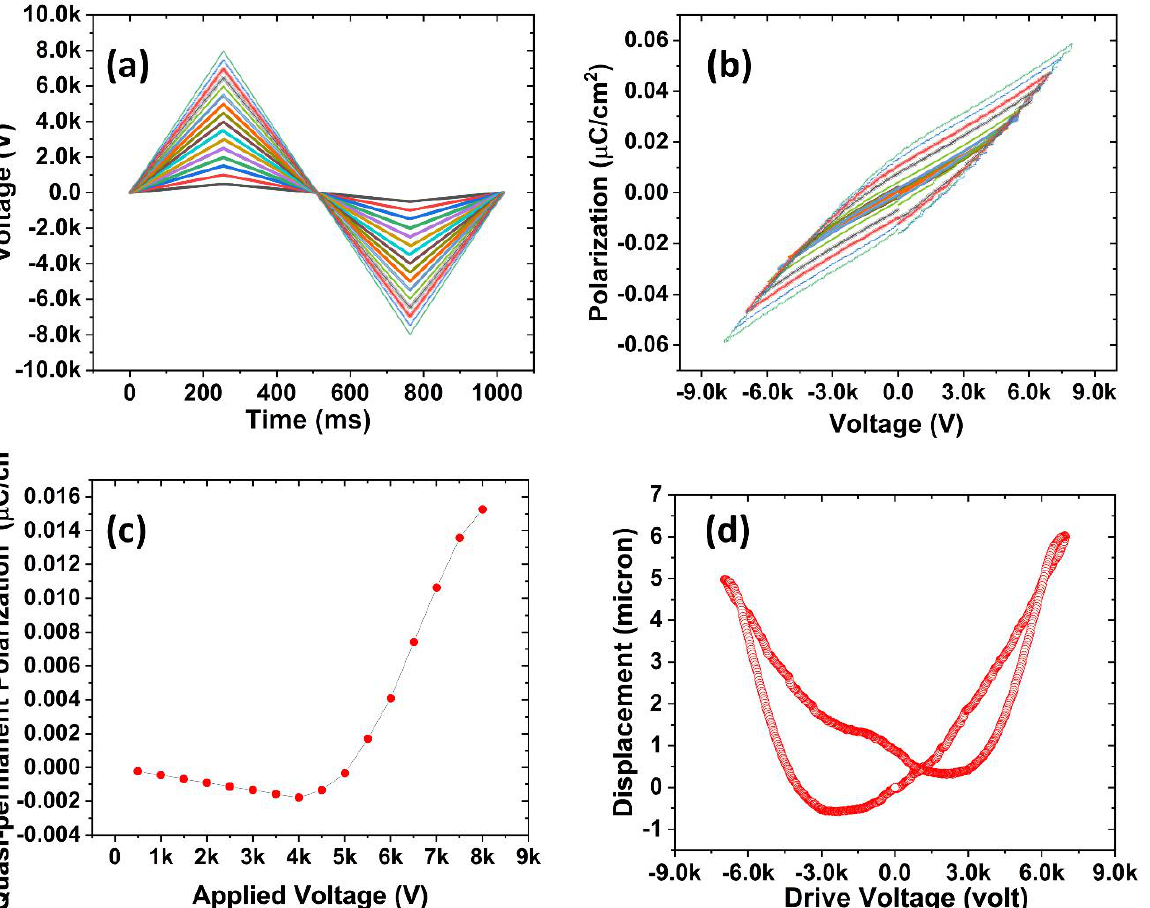
Figure 3. ( a ) AC-biased voltage applied to the material to study the charging process of the piezoe- lectric material. ( b ) Electrical hysteresis loop for the honeycomb structure during charging. ( c )